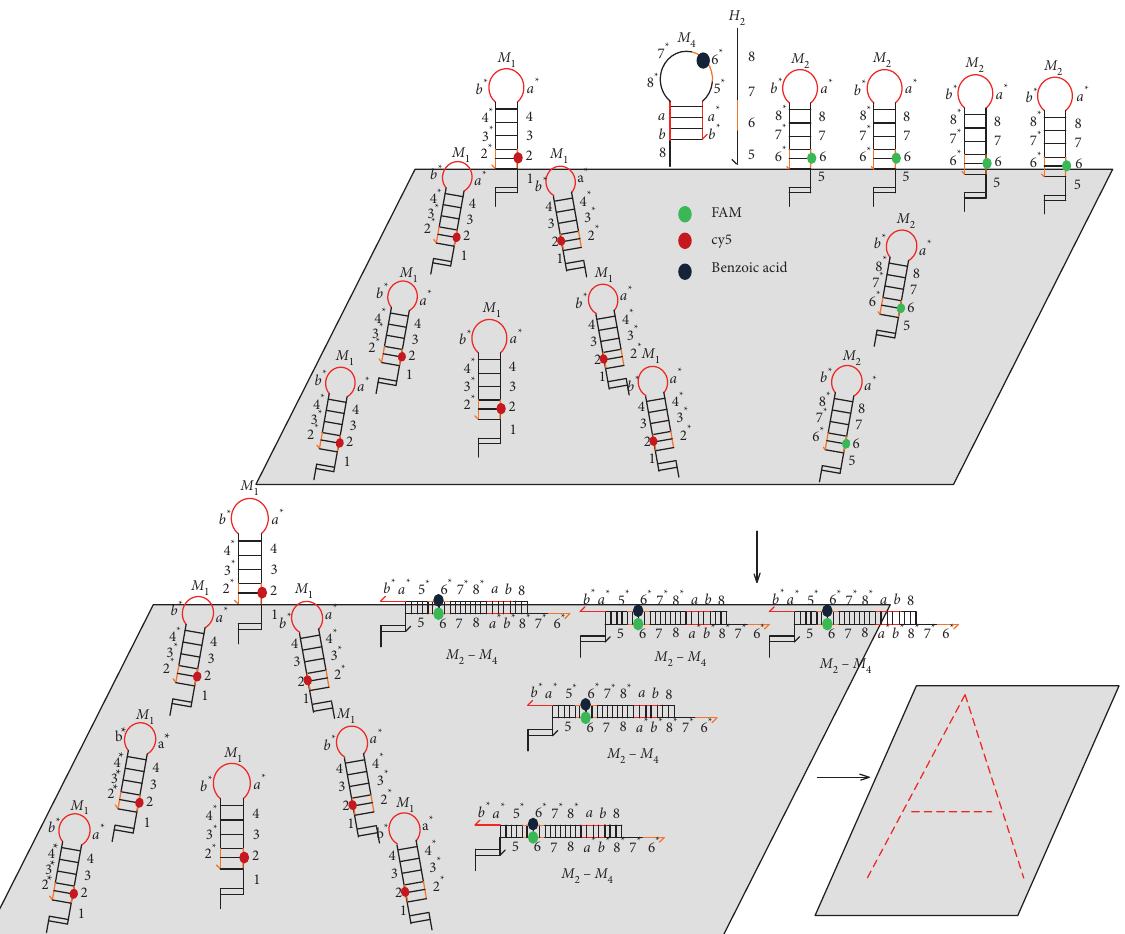
Figure 13: The case of NAND gate input (0,